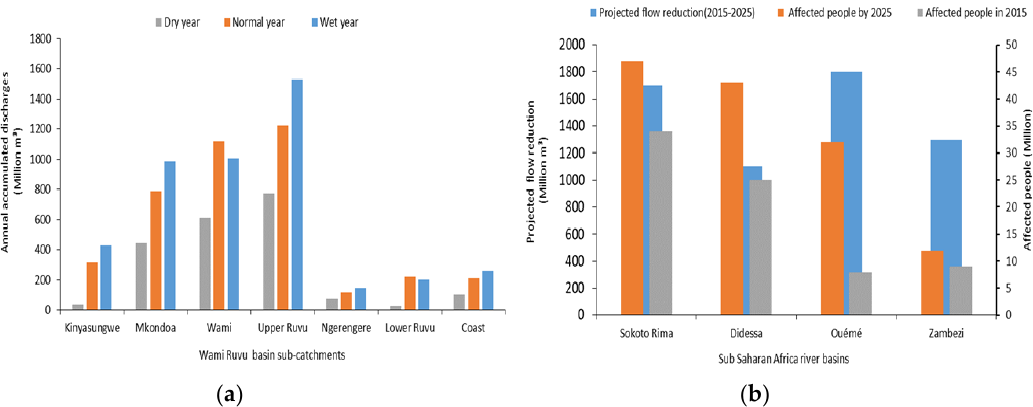
Figure 3. Variation in basin flow: ( a ) annual accumulated discharge in the Wami Ruvu basin; ( b ) annual flow reductions and affected riparian areas in Sub-Saharan Africa (selected basins).